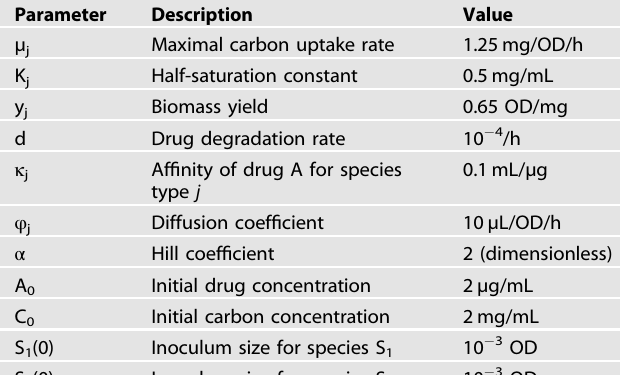
Table 1. Model parameters for Eqs. 1a – d, 2 and 3.